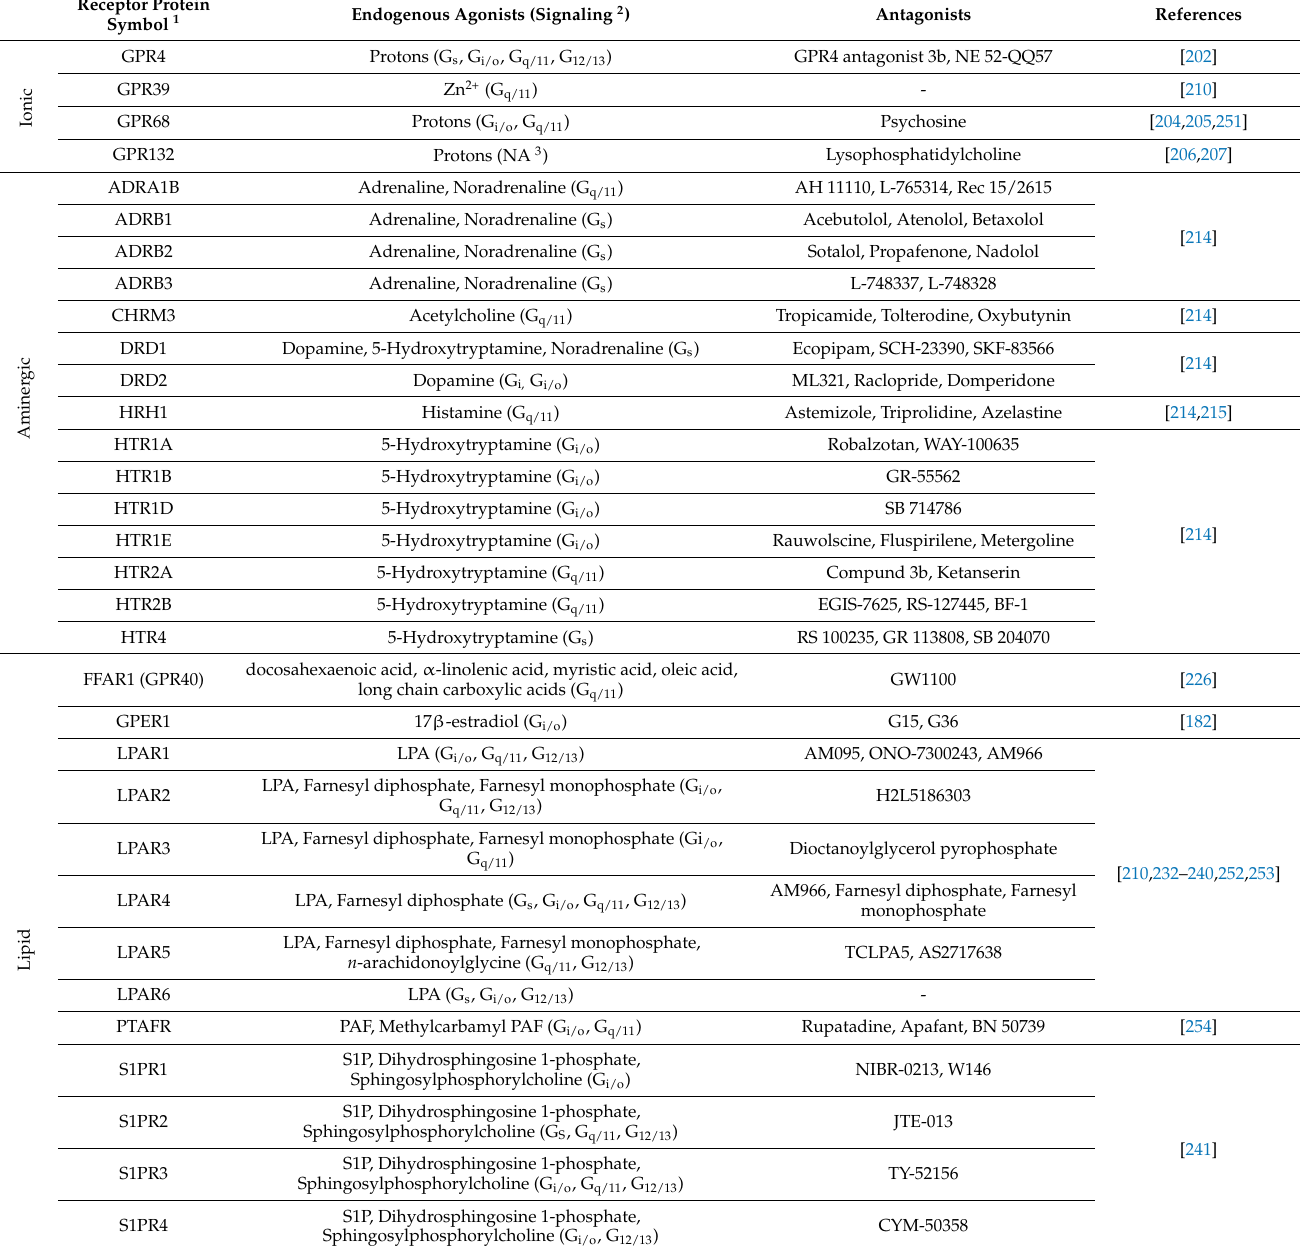
Table 3. GPCRs expressed in ovarian